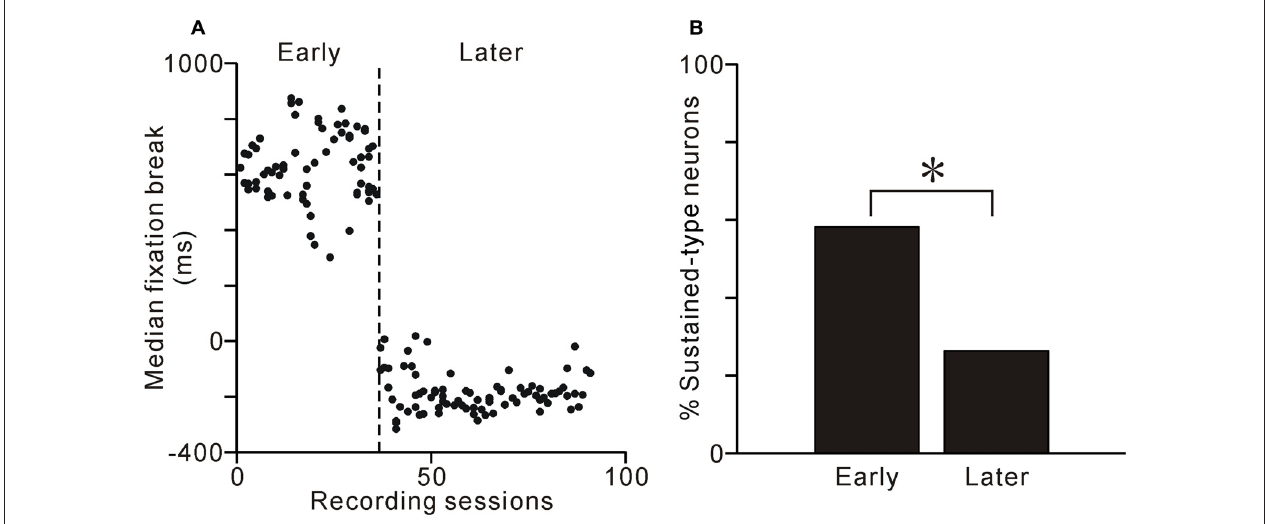
FIGURE 8 | Learning-related changes in behavior and proportions of neuron types. (A) Median time of fixation break relative to reward delivery are plotted against recording sessions for monkey 1. (B) Proportion of sustained-type neurons during the early and later periods. The proportion of sustained-type neurons was smaller in the later period than in the early period. ∗ p < 0.01, χ 2